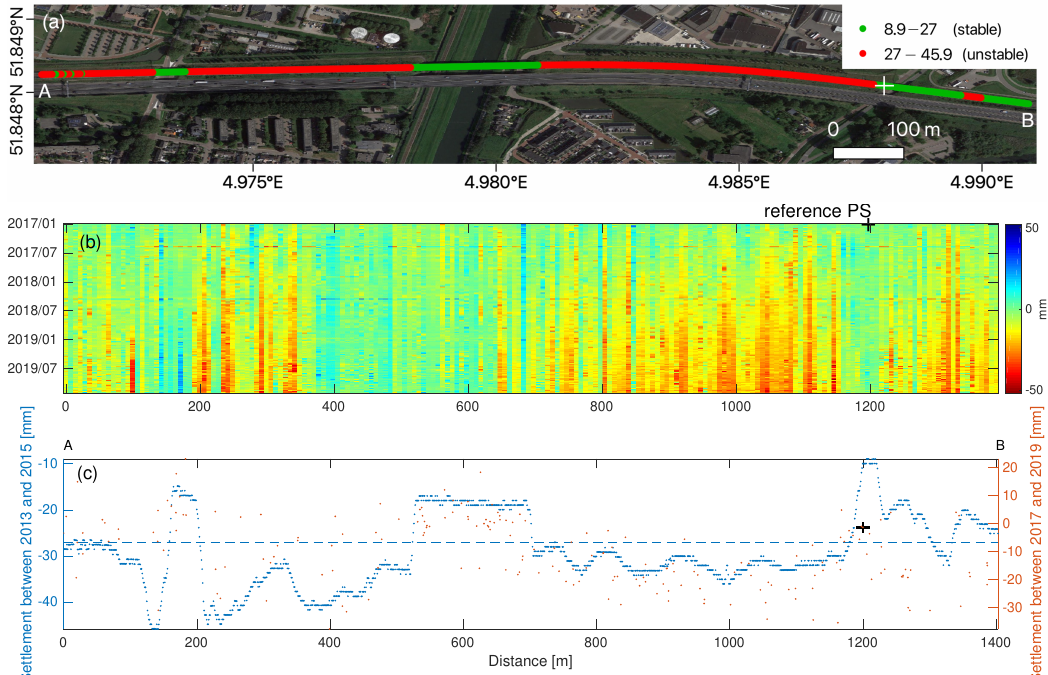
Figure 9. ( a ) Risk map over the segment A-B using the Rail Infrastructure aLignment Acquisition (RILA) data. The local reference PS point is indicated in the cross. ( b ) Cumulative settlement map for 196 PS points. ( c ) Settlement difference between January 2013 and February 2015 in blue and settlement difference between 4 January 2017 and 8 December 2019. The blue dashed line indicates the settlement threshold with the value of 27 mm. The location of the A-B segment is also indicated in Figure